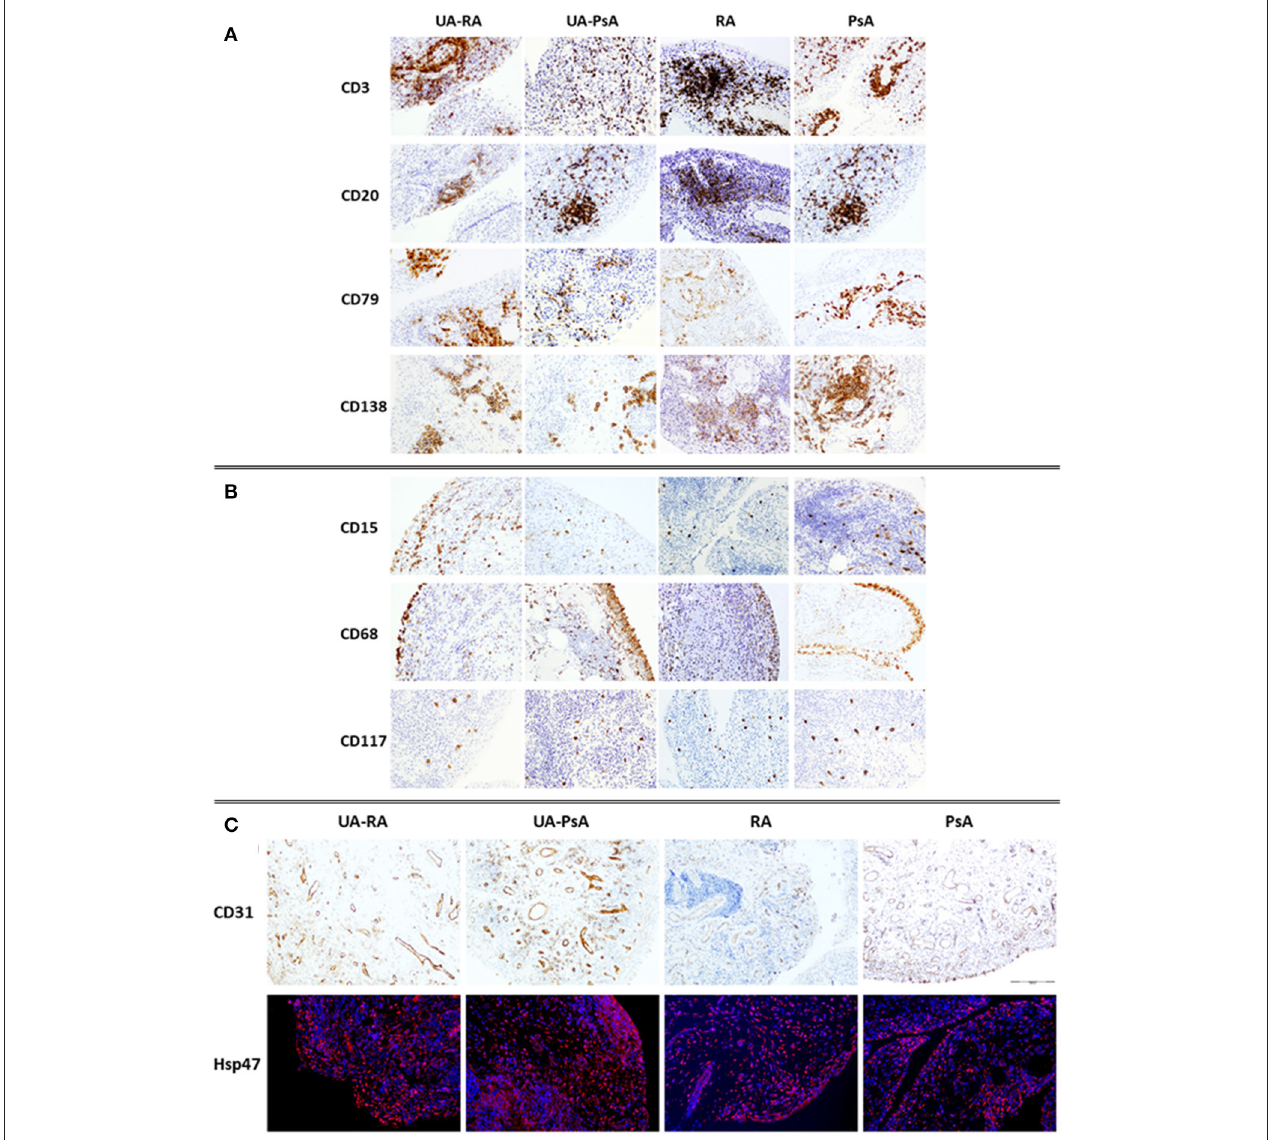
FIGURE 3 | Immunostaining of cellular infiltrate in synovial membrane of UA-RA, UA-PsA, RA and PsA patients. (A) Adaptive immune cells (CD3, CD20, CD79, and CD138, 20 × ); (B) innate immune cells (CD68, CD15, and CD117, 20 × ); and (C) stroma cells (CD31, 10 × ) and Immuno-fluorescence labeling of fibroblast Hsp47 + (red) in sections from synovial tissue. DAPI (blue) nuclear counterstained; original magnification 20 × . RA, rheumatoid arthritis; PsA, psoriatic arthritis; UA, undifferentiated arthritis evolving to RA (UA-RA) or PsA